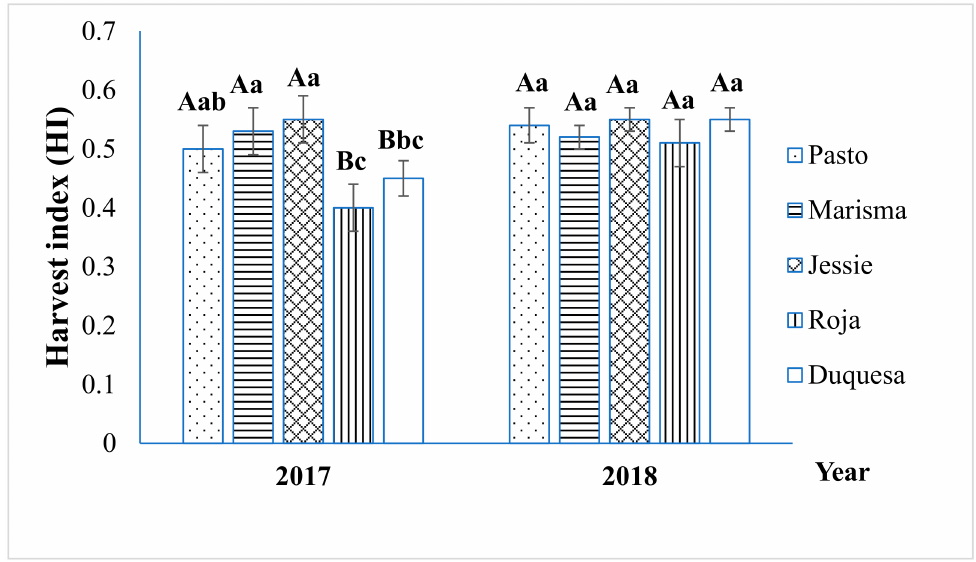
Figure 2. Harvest index (HI) of five quinoa varieties during the two years (2017 and 2018) of field experiments. Error bars represent the standard deviation (SD). Different uppercase letters in the same variety indicate a significant difference between years according to Student’s t -test at p < 0.05. In each year, different lowercase letters indicate significant differences among varieties according to Tukey’s test at p <